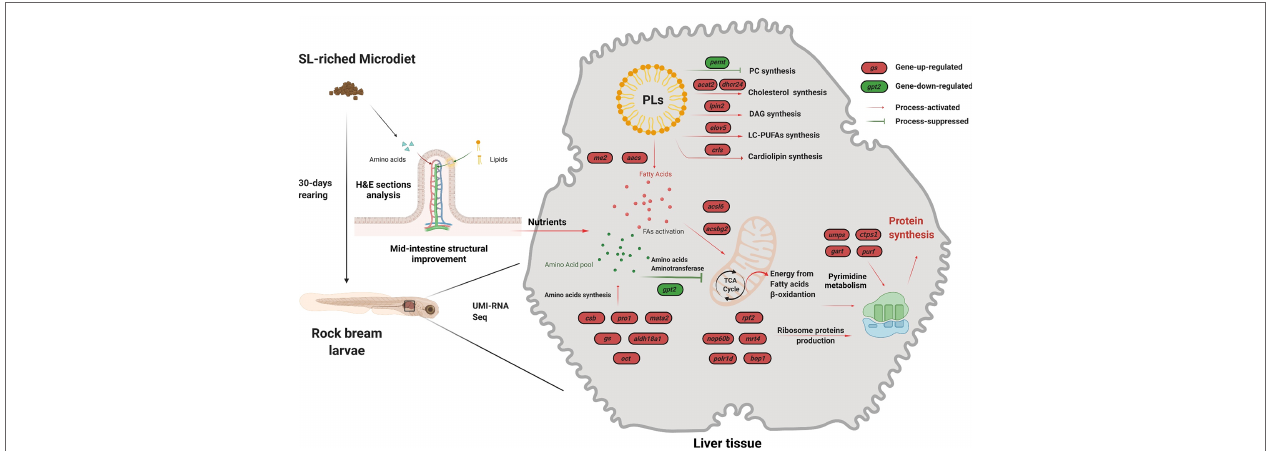
FIGURE 5 | Schematic representation of the effects of the PL-rich (SL12) diet on intestine morphology and liver tissue molecular response. Transcriptome analysis was used to elucidate the potential molecular mechanisms underlying the observed results. The red ovals indicate upregulated genes, and the green ovals indicate downregulated genes. The SL12 diet improved the mid-intestine structure and thereby increased nutrient acquisition. The UMI-RNA sequencing results indicated that the SL12 diet could increase the de novo synthesis of lipids other than phosphatidylcholine. The SL12 diet increased energy production from fatty acid β -oxidation by fatty acid activation but decreased amino acid aminotransferase activity in the TCA cycle. The SL12 diet increased amino acid synthesis and ribosome production-related gene expression.